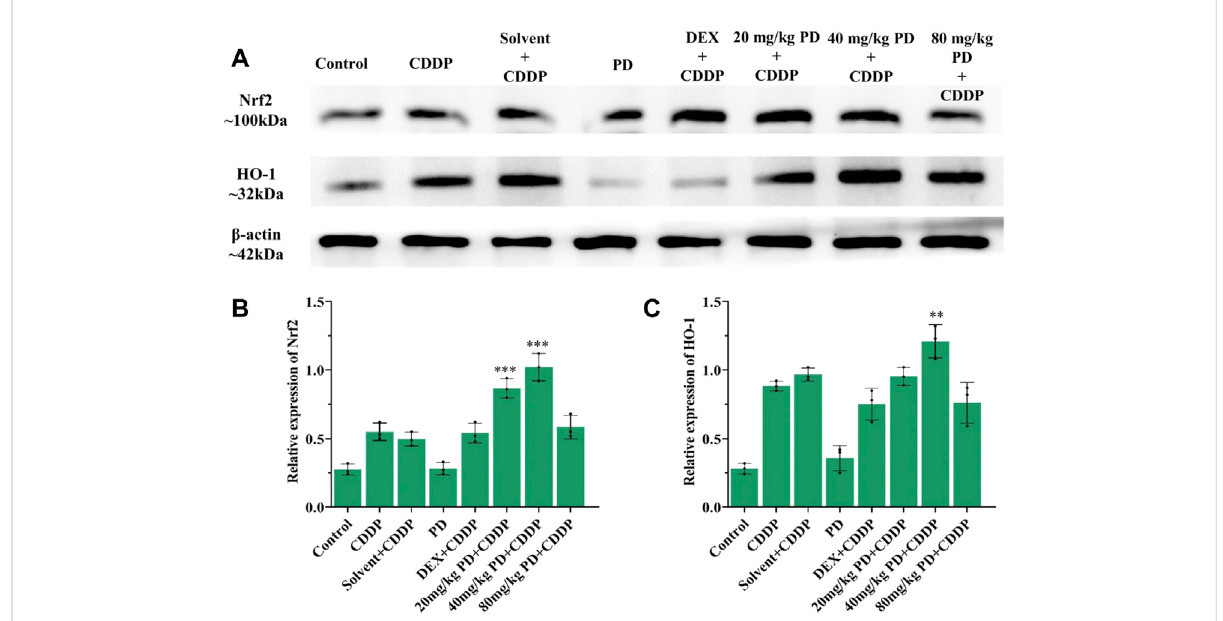
FIGURE 9 PDpromotestheactivationofNrf2/HO-1signalingpathwayinthecochleaaftercisplatinadministration. (A) TheexpressionofNrf2andHO-1in each group after 3 days of drug administration. (B) and (C) PD administration before cisplatin increased the expression of Nrf2 and HO-1 in a concentration-dependent manner, presenting as PD (40 mg/kg) > PD (20 mg/kg) > PD (80 mg/kg). The effect of PD (40 mg/kg) was better than that of DEX (10 mg/kg, multi-dose) ( p < 0.001). PD (40 mg/kg) injection alone did not improve the expression of Nrf2 and HO-1. n = 3. ** p < 0.01, *** p < 0.001, all versus the CDDP group. Error bars representmean ±